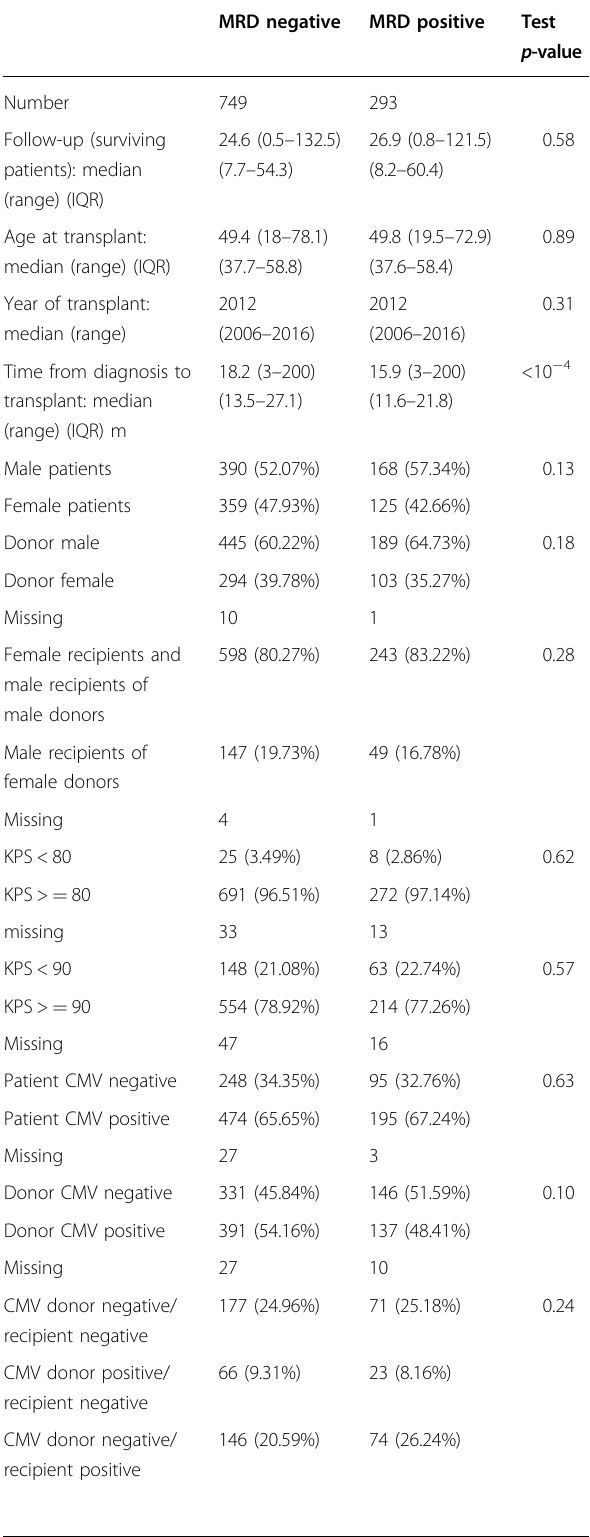
Table 1 Patient and transplant